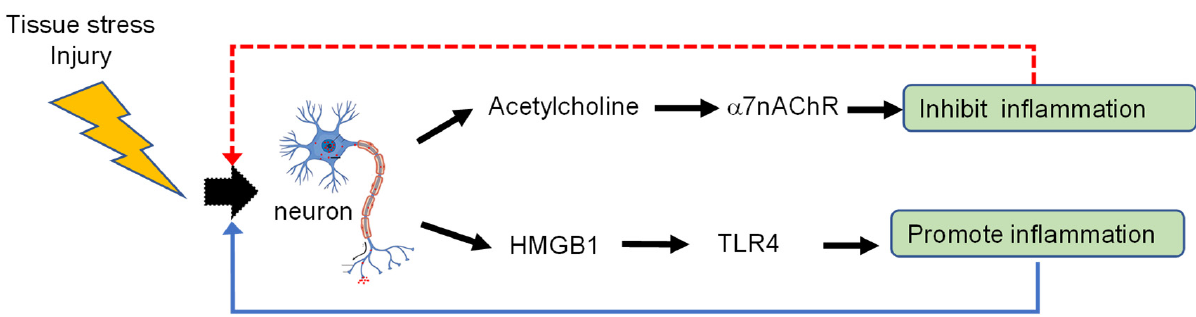
Figure 5. Neurons regulate the inflammatory milieu. Neurons both activate inflammation via release of HMGB1 and other pro-inflammatory molecules, as well as inhibit inflammation via acetylcholine release from vagal nerve fibers (the inflammatory reflex) [60]. However, these actions also feedback upon neurons to provide inhibition (red dashed line) to counter-balance further amplification (blue solid line) of inflammation. The discovery that neuronal HMGB1, a well characterized endogenous pro-inflammatory mediator, is a fundamental driver of the cascade of immune system defense provides a mechanism by which the nervous system provides yin–yang control of anti- and pro-inflammatory factors to maintain homeostasis.